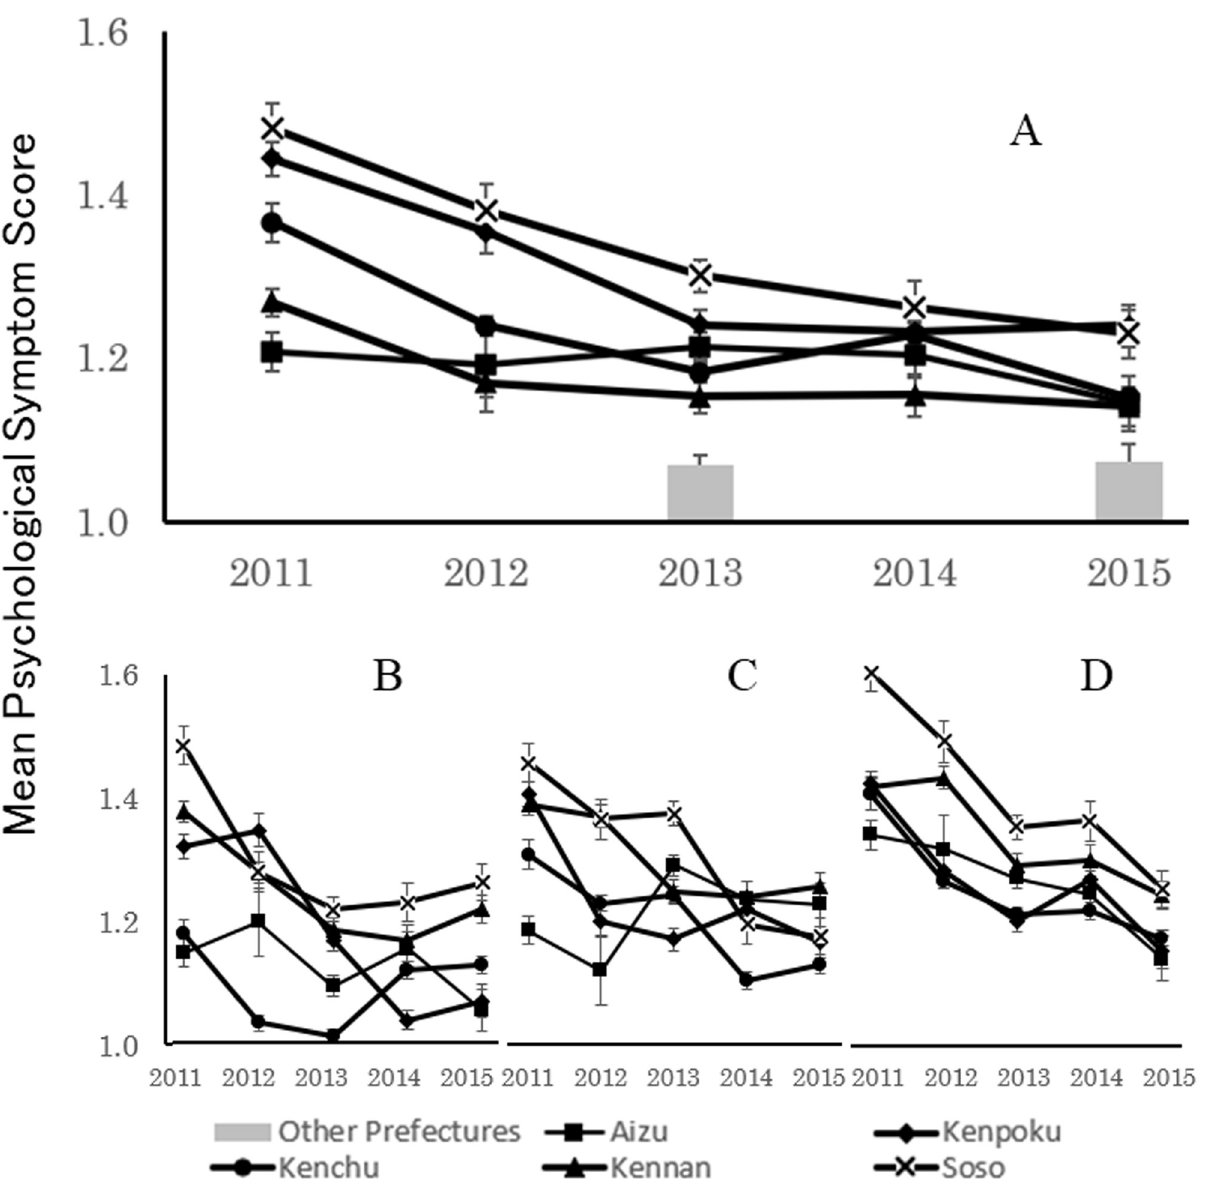
Fig 2. Transition over time in psychological symptom levels (Mean ± SE) of mothers residing in low-contamination regions. Panels B-D present data for mothers of four, 18, and 42-month-old children, respectively. In Panel A, the data for all mothers are combined.